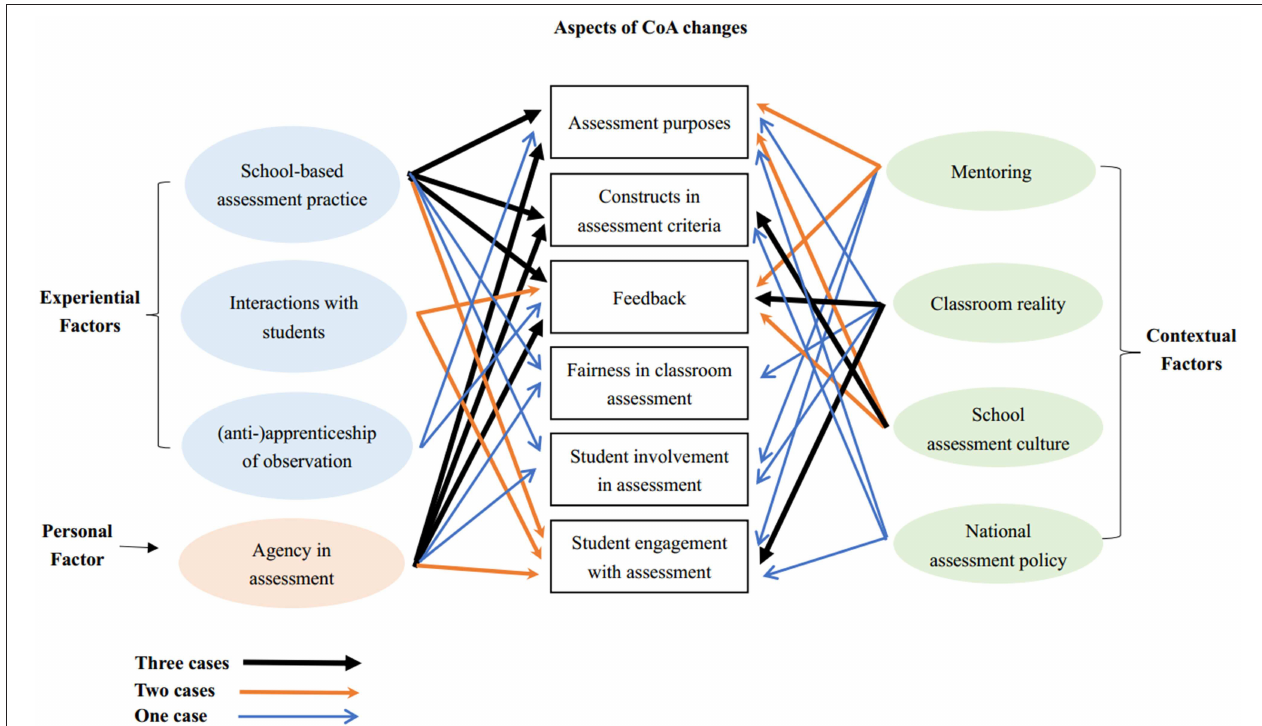
FIGURE 1 | Pre-service teachers’ conception-of-assessment (CoA) changes and influential factors during